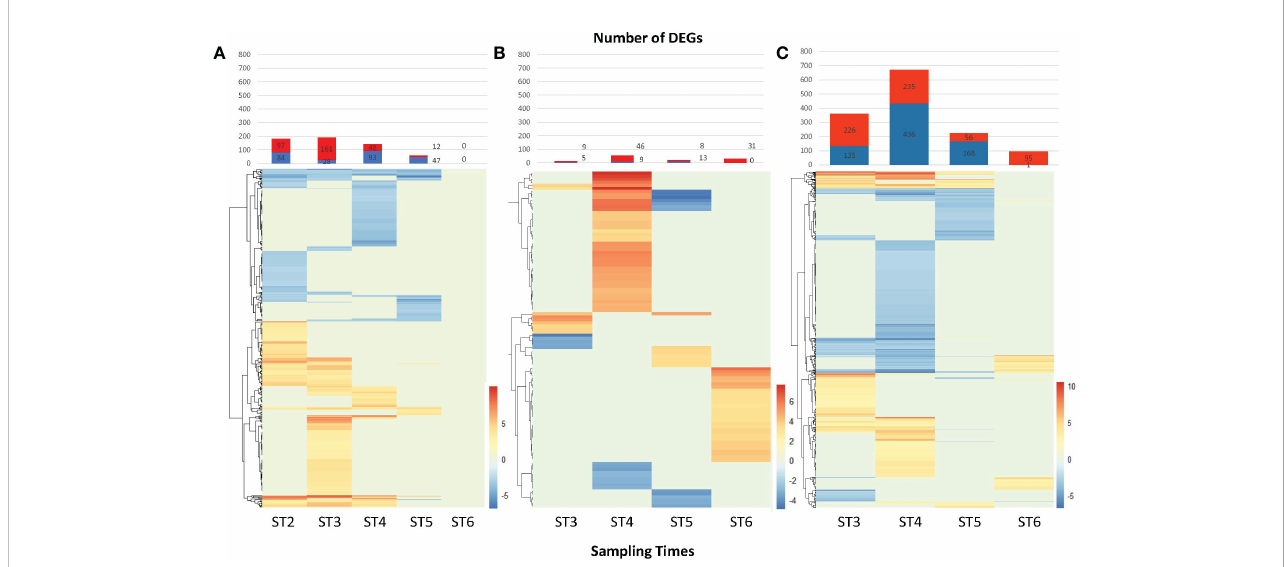
FIGURE 5 Differentially expressed genes (DEGs) identi fi ed under drought, heat, and combined treatments. Bar plots indicate the number of DEGs (FDR adjusted P- val. < 0.05) identi fi ed per treatment and sampling point. Red and blue bars indicate the number of up-regulated and down-regulated genes, respectively. Heatmaps show the fold change of the identi fi ed DEGs. (A) DEGs identi fi ed under drought treatment, (B) Heat, (C) Combined (heat plus drought). Heat and combined stress had not been initiated at ST2; therefore, it is not included in here.